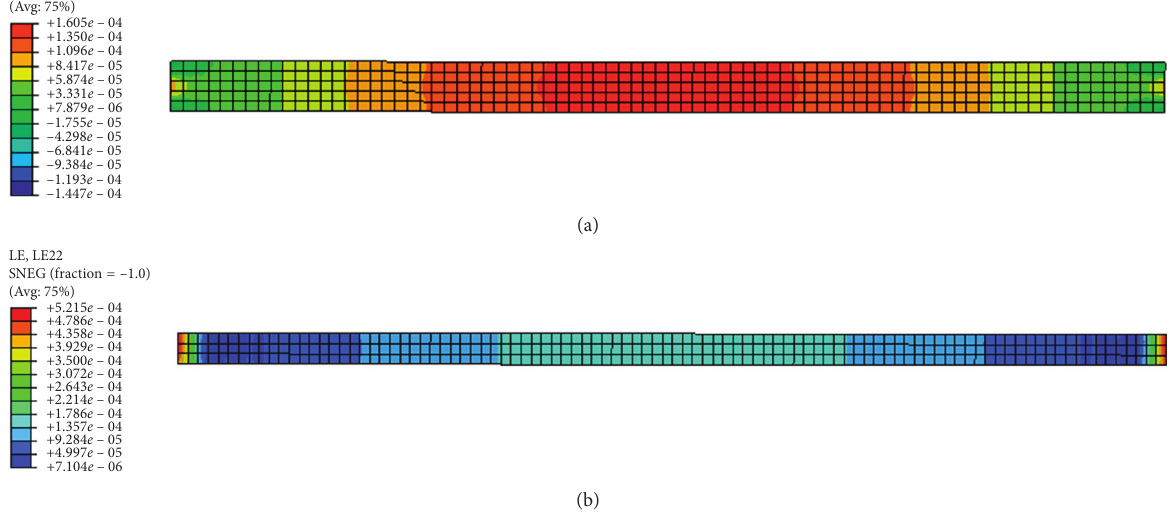
Figure 5: Strain distribution under the temperature of 25 ° C. (a) Bottom flange of the steel beam. (b) CFRP sheet.